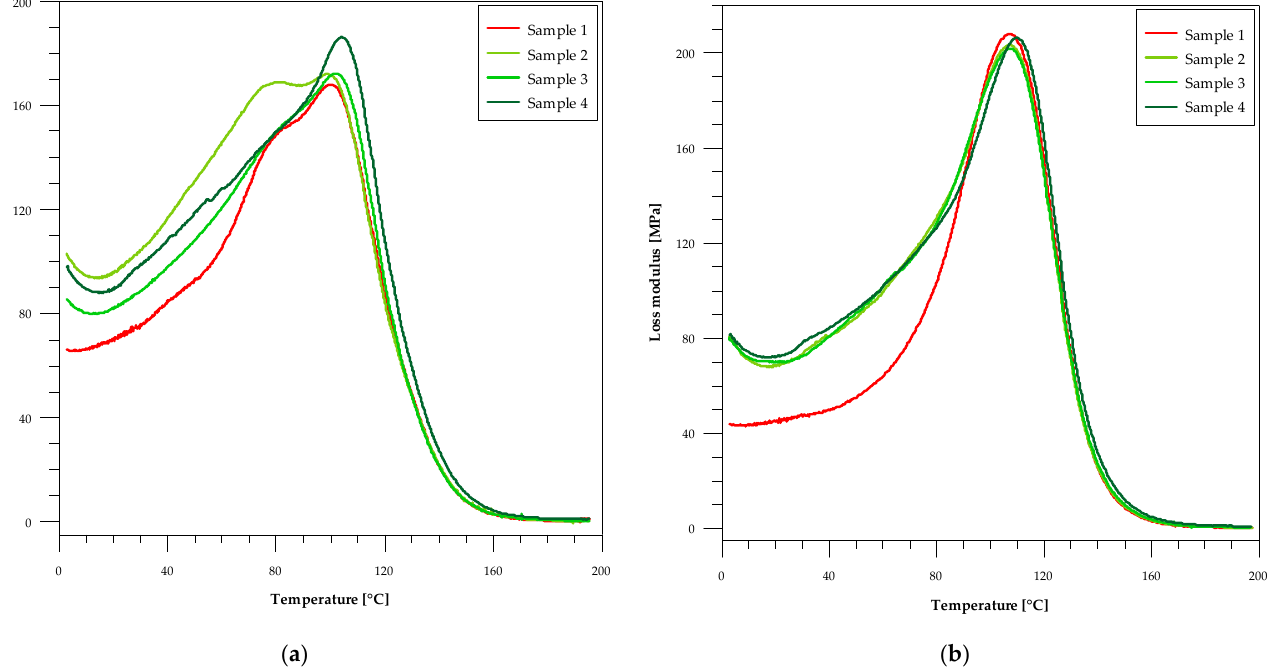
Figure 2. The temperature-dependent graph of loss modulus (E”) for samples with wood flour. ( a ) Before the accelerated aging test and ( b ) after the accelerated aging